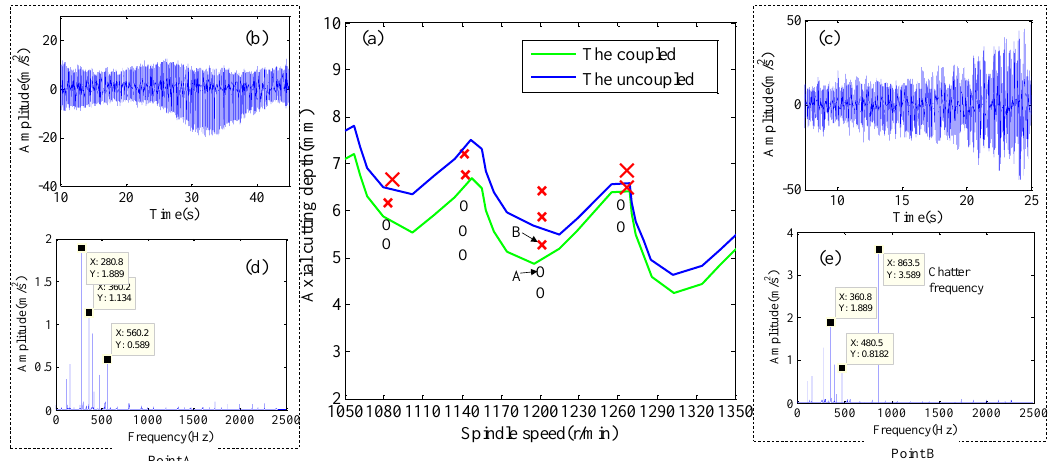
Figure 7. Validation of milling process stability. ( a ) Stability lobes diagram, ( b ) The acceleration signal at A point, ( c ) The acceleration signal at B point, ( d ) Frequency spectrum diagram at A point acceleration signal ( e ) Frequency spectrum diagram at B point acceleration signal.